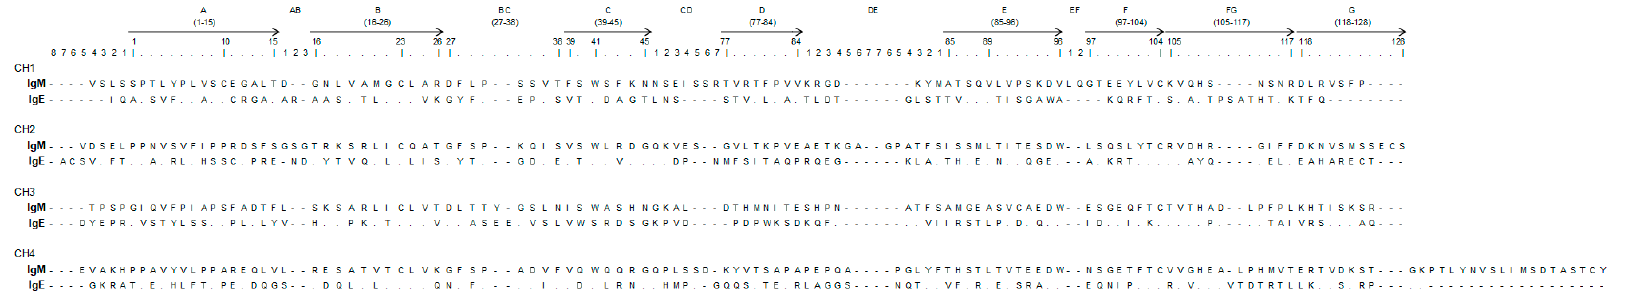
Figure 1. European rabbit ( Oryctolagus cuniculus ) IgM and IgE DNA sequences of constant regions (Genbank accession numbers for IGHM: J00666, and IGHE: AY386696.1). The amino acid translation is shown. The IMGT unique numbering for the constant domain (13) is shown on top.